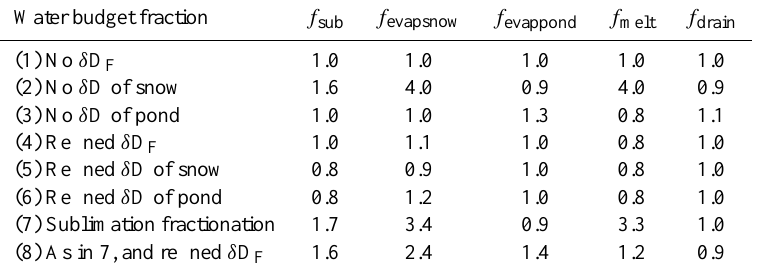
Table 2. Fractional change in uncertainty of partition fractions from a series of eight sensitivity tests. Change in uncertainty is reported as the fractional change in the 25–75th percentile range. Values higher than one show that the range of values has increased, values lower than one means that the range of values is decreased. Tests 1, 2 and 3 remove each of δ D F , δ D of snow and δ D of ponds. Test 4, 5 and 6 use uncertainty in those values reduced by a factor of two. Test 7 allows for fractionation during sublimation. Test 8 combines test 7 with reduced uncertainty in the estimate of δ D F .